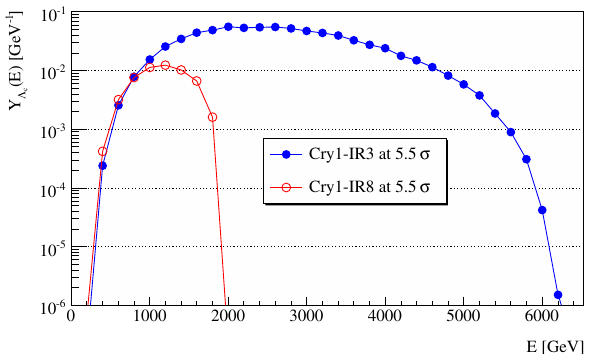
Fig. 15 Expected yield of (cid:2) c emerging from the Cry 2 that acquired the desired precession in 10 h LHC fill with the Cry 1 at 5 . 5 σ